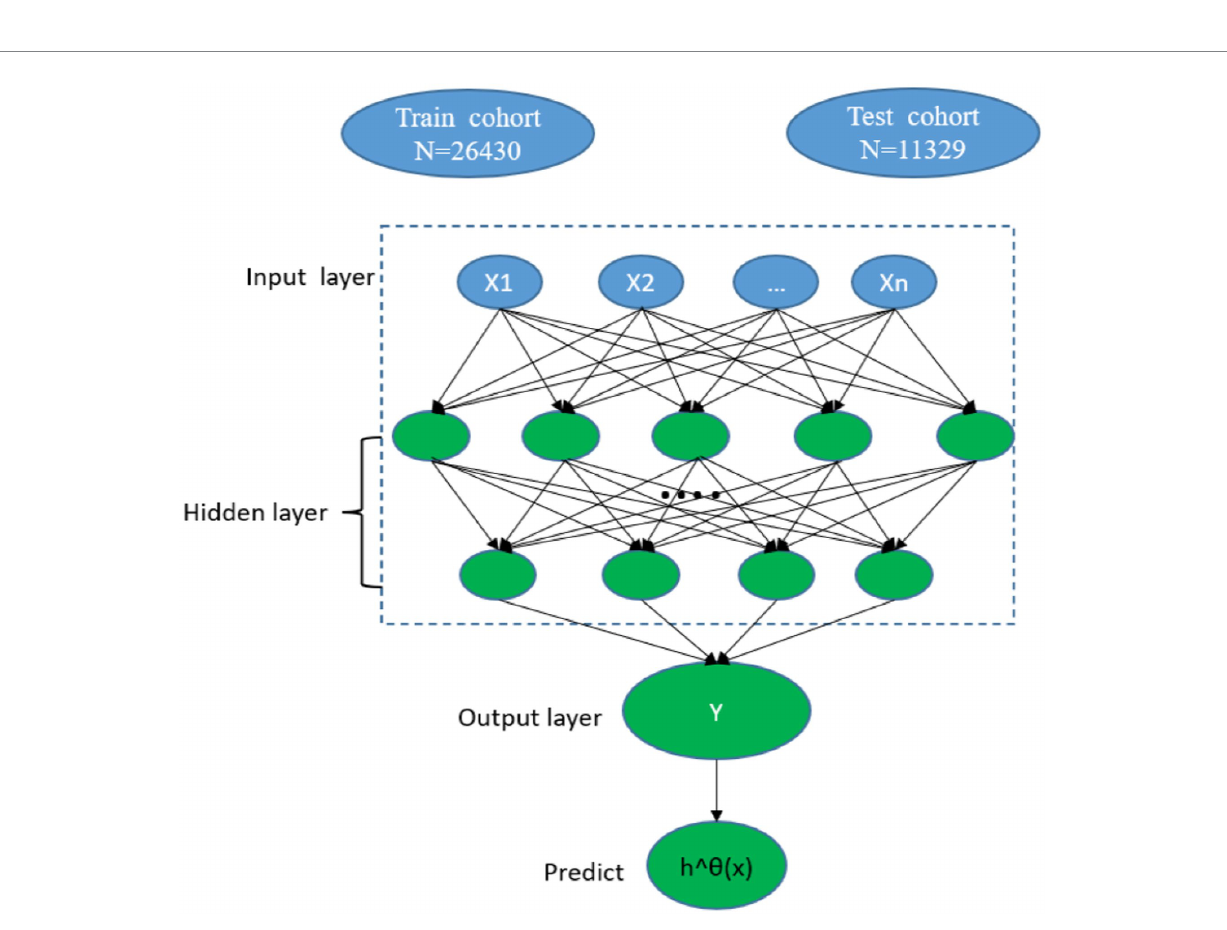
FIGURE 2 Diagram of the deep learning